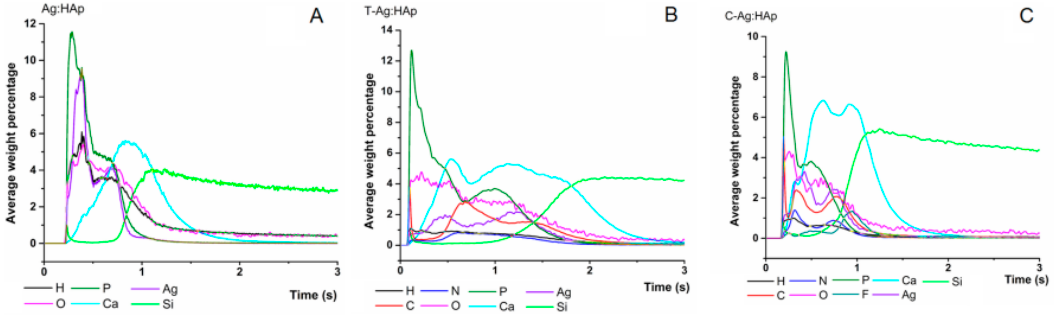
Figure 10. Depth profile curves of Ag:HAp ( A ); T-Ag:HAp ( B ) and C-Ag:HAp ( C ) thin films.